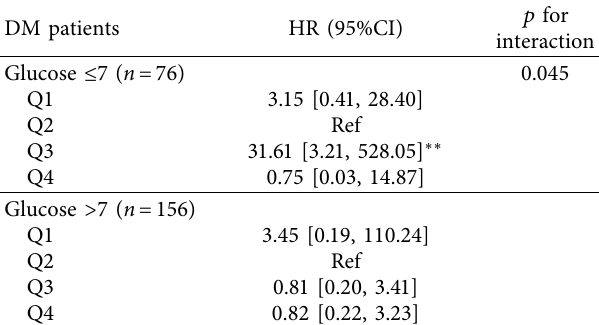
2020–010). All methods were carried out in accordance with Helsinki regulations.